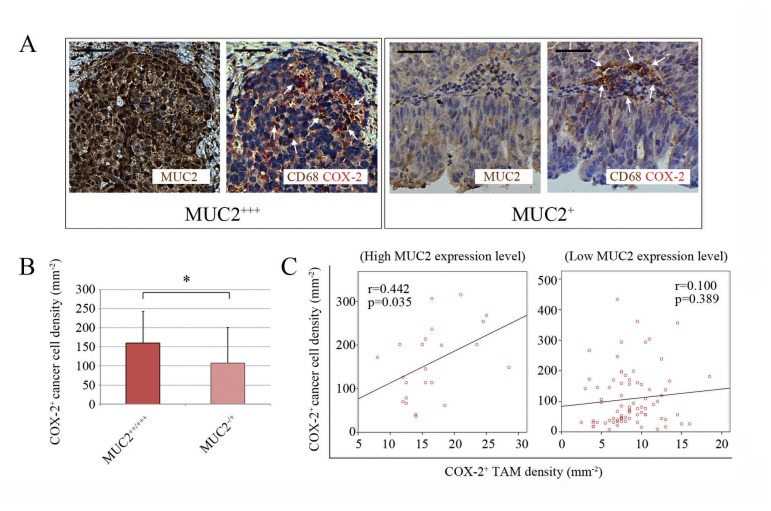
Correlation of the COX-2 expression statuses of the cancer cells and TAMs.(A) Representative microscopic fields in cancer tissue sections from the high and low MUC2 expression groups. In the cancer tissue sections from the high MUC2 expression group, COX-2+ cancer cells and COX-2+ TAMs (with cytoplasm in red) were frequently distributed throughout the entire islet region, whereas in the cancer tissue from the low MUC2 expression group, COX-2+ cancer cells and COX-2+ TAMs were both observed less frequently. Arrow, CD68+ TAMs (left, CD68+COX-2+ TAMs in purple; right, CD68+COX-2- TAMs in brown). Scale bar, 50 μm. (B) Comparison of the COX-2+ cancer cell densities between the high and low MUC2 expression groups. *, p<0.05, Student’s t-test. (C) Scatter plots of the COX-2+ cancer cell density versus the COX-2+ TAM density in specimens from the high (23 cases) and low MUC2 expression (79 cases) groups. r, Pearson’s product-moment correlation coefficient.